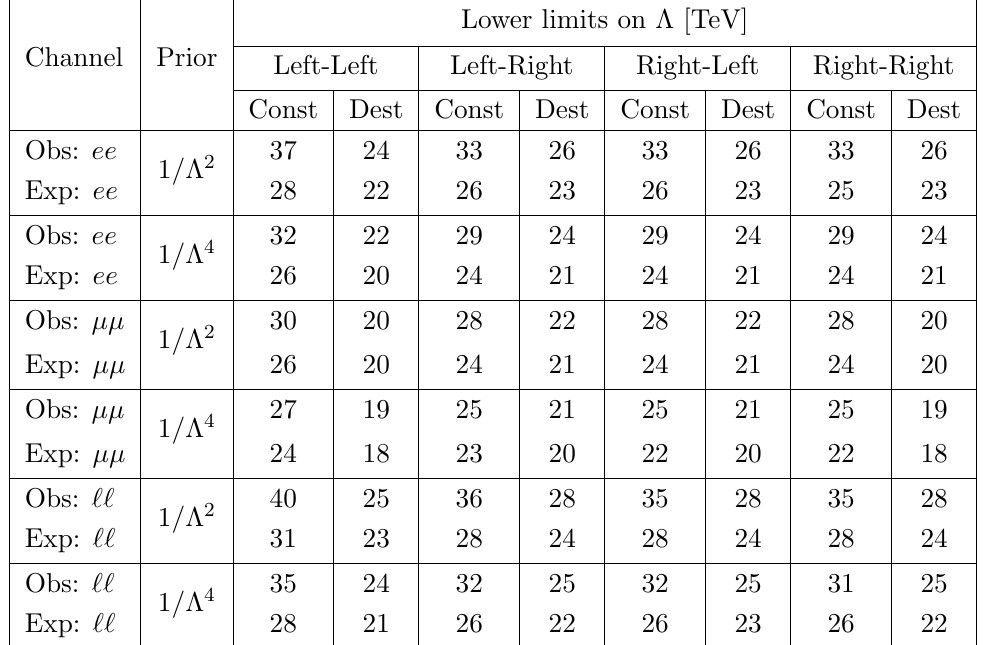
Table 7 . Observed and expected 95% CL lower limits on (cid:3) for the LL, LR, RL, and RR chiral coupling scenarios, for both the constructive (const) and destructive (dest) interference cases using a uniform positive prior in 1/(cid:3) 2 or 1/(cid:3) 4 . The dielectron, dimuon, and combined dilepton channel limits are shown, rounded to two signi(cid:12)cant